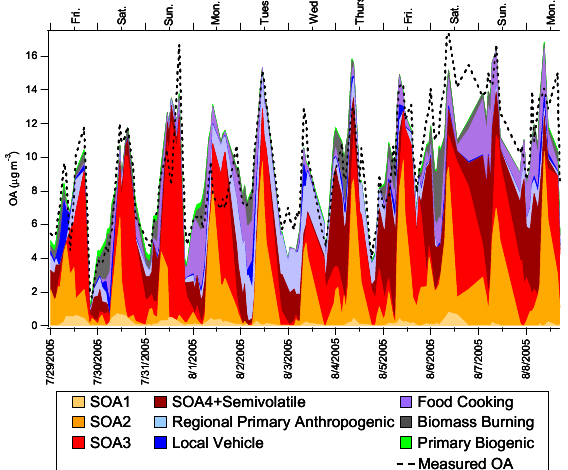
Fig. 9. Factor contributions to PM 1 organic aerosol mass concen- trations during the fall focus period (4 November–14 November). Dates are labeled at the beginning (midnight PST) of that